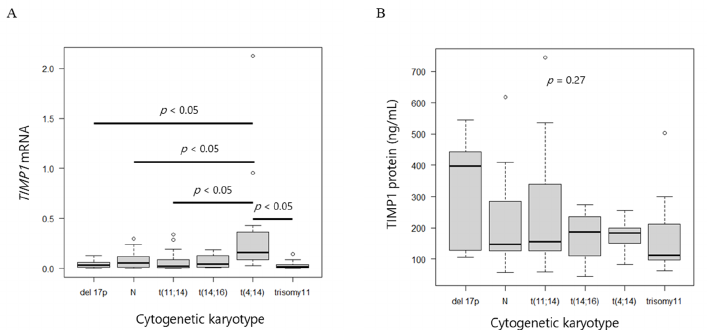
Figure 3. TIMP1 mRNA and protein levels. ( A ) Box plot of TIMP1 mRNA levels and ( B ) TIMP1 protein levels among different cytogenetic abnormalities.